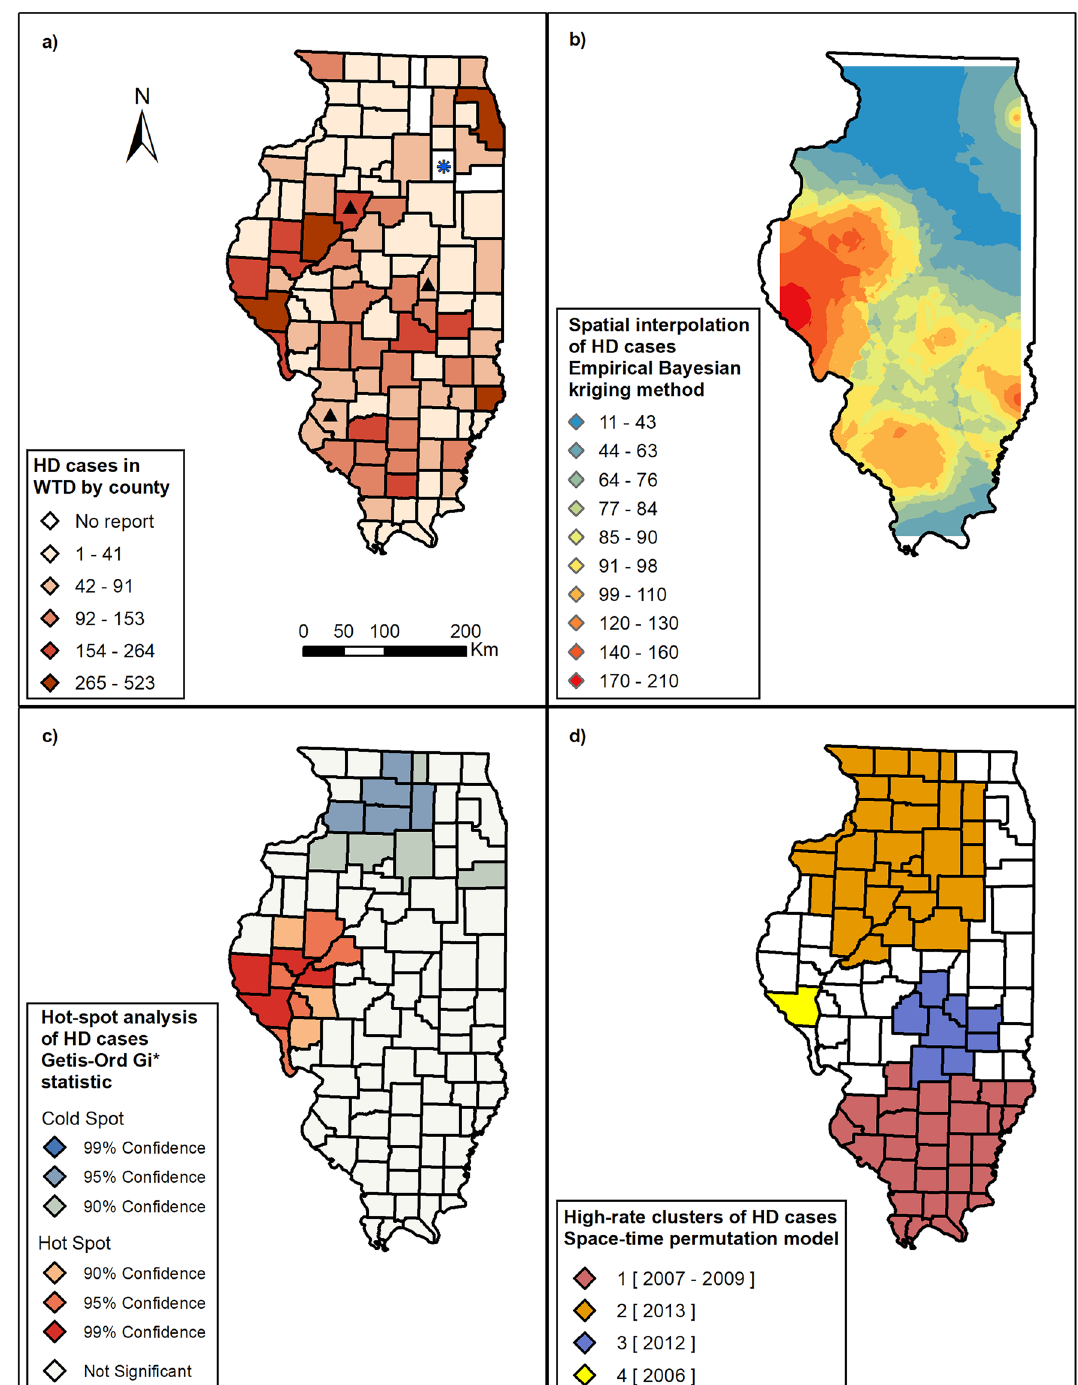
Figure 3. Hemorrhagic disease (HD) in wild white-tailed deer in Illinois between 2006 and 2019. ( a ) Distribution of the total number of HD cases by county in Illinois.; the asterisk indicates county where there is no numerical data, but HD has been reported as present; the triangles indicate counties in which Bluetongue was identified in wild white-tailed deer. ( b ) Isopleth map illustrating the distribution of HD cases across Illinois by using the Bayesian kriging spatial interpolation empirical method. ( c ) Hot-spot analysis of HD cases in wild white-tailed deer by using Getis-Ord Gi* statistic. ( d ) High rate clusters of HD cases identified by the space– time permutation scan statistic. Maps created using ArcGIS 10.7.1 (ESRI Inc., Redlands, CA,